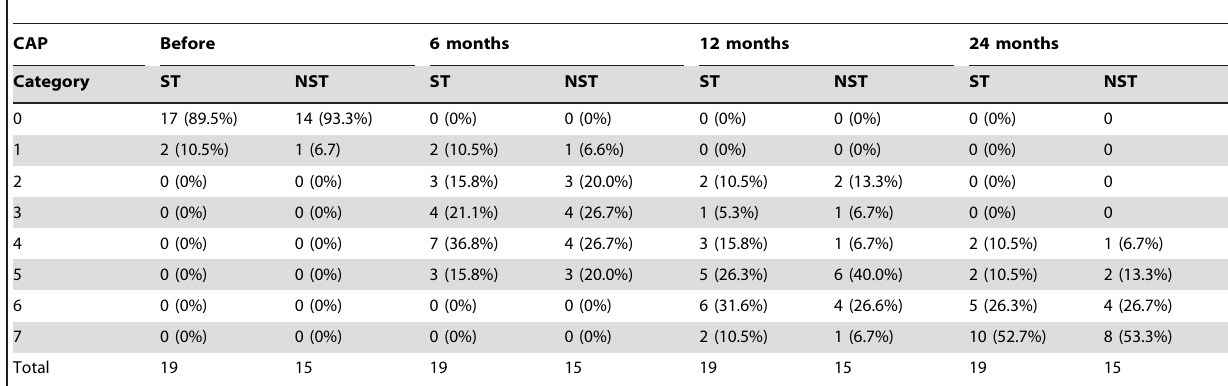
Table 1. Numbers of patients in each CAP category before implantation, 6, 12, 24 months after implantation.